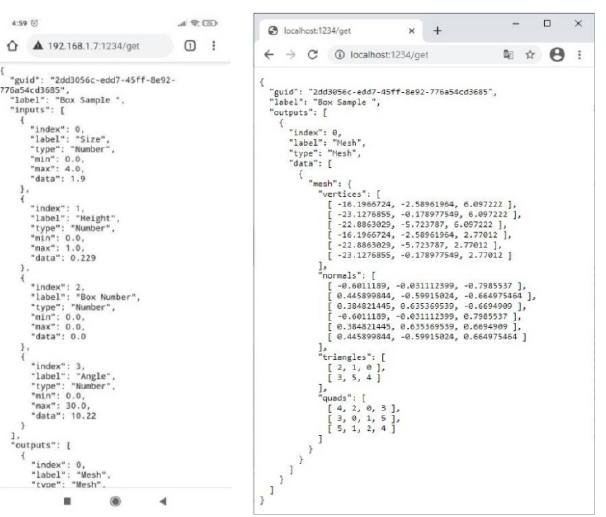
Figure 6. REST API Server sample request accessed through a mobile device ( left ) and sample response accessed through a web browser ( right ) running Grasshopper3d definition in headless mode.